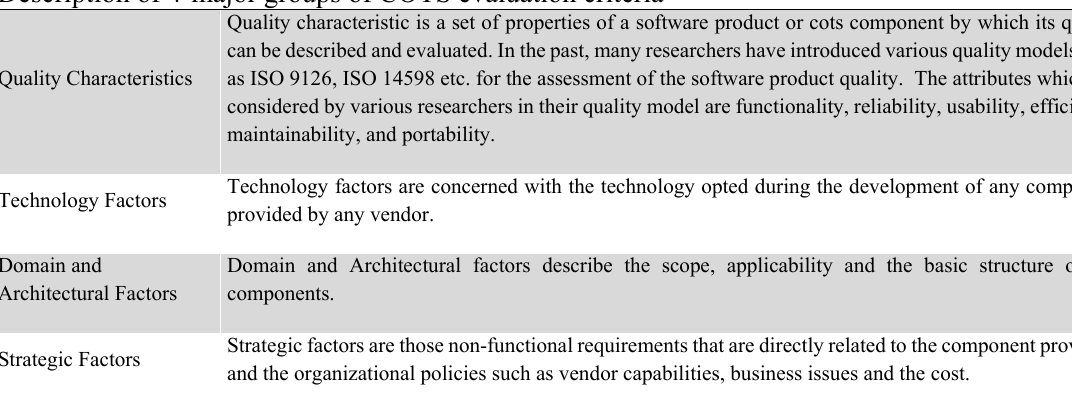
Description of 4-major groups of COTS evaluation criteria Quality